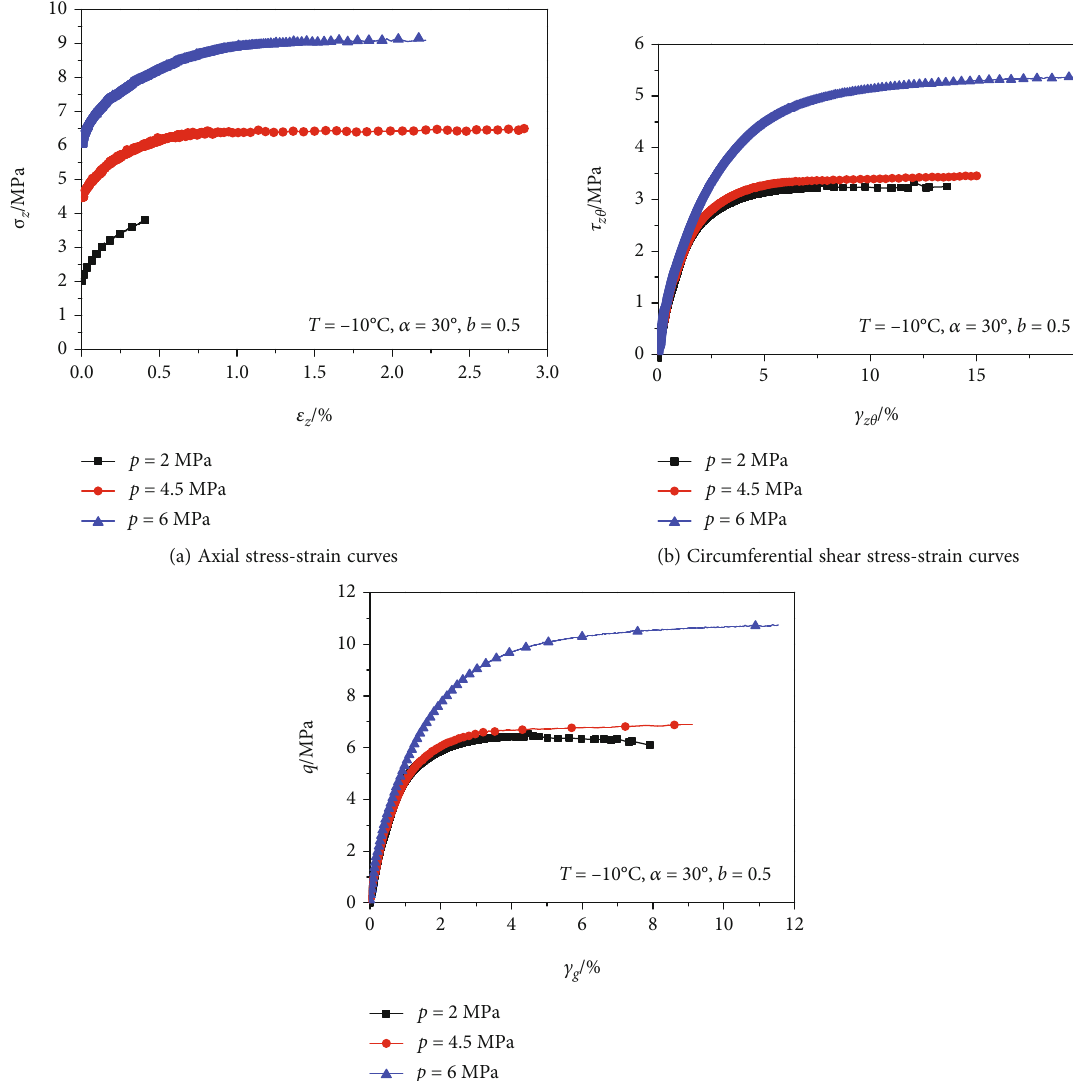
Figure 14: Stress-strain curves of the FSS under di ff erent mean principal